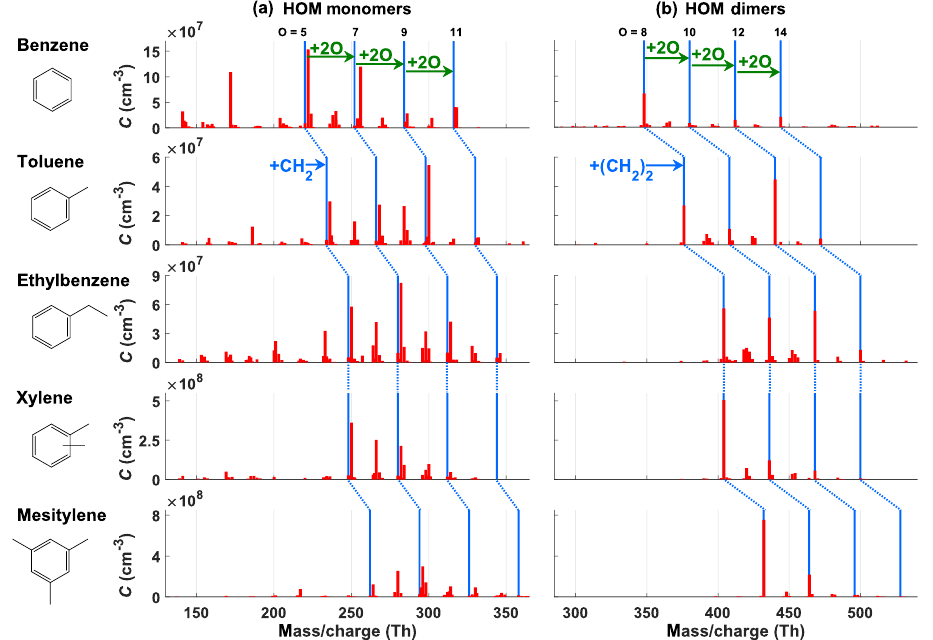
Figure 2. Mass spectra (displayed in red) of HOMs from five monocyclic ArHCs (benzene, toluene, ethylbenzene, xylenes, mesitylene). HOM monomers (a) have the same number of carbon atoms as the precursor, while HOM dimers (b) have twice as many. Green arrows in the benzene panel show a sequence of peaks separated by a mass corresponding to two oxygen atoms. This may be connected to the autoxidation mechanism which proceeds through the addition of O 2 molecules. The same sequence is seen in the other ArHCs, which we have indicated by the blue dashed and solid lines to guide the eye of the reader. The initial peak and the corresponding sequence of the five single-ring ArHCs are shifted by a CH 2 unit due to the different substituents (blue arrow in the toluene panel). HOMs with the same number of oxygen atoms can have a different number of hydrogen atoms ( n , n + 2, n + 4). Note the different peak intensity patterns observed for